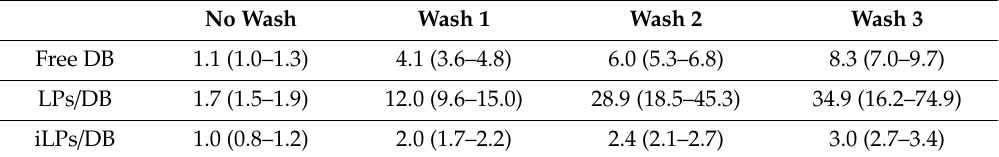
Table 2. DB IC 50 values ( µ M) in in vitro P. falciparum cultures. 95% confidence intervals are indicated